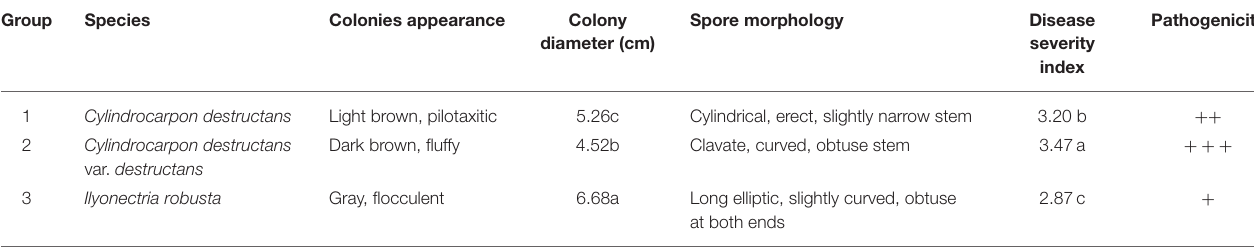
TABLE 3 | Morphological data and pathogenicity test of Cylindrocarpon isolated from ginseng RRR. Group